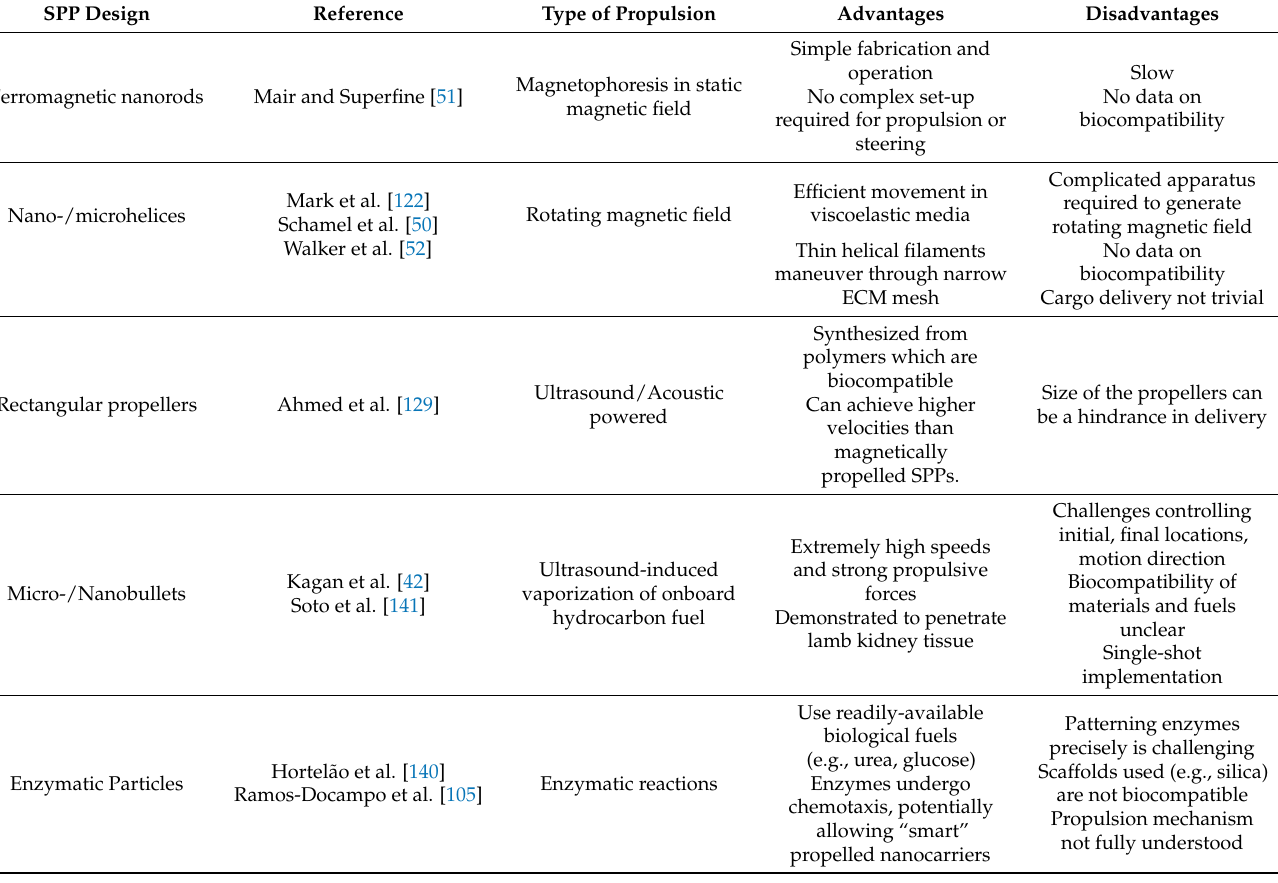
Table 1. Summary of the different SPPs as well as the advantages and disadvantages of their mode of propulsion. SPP